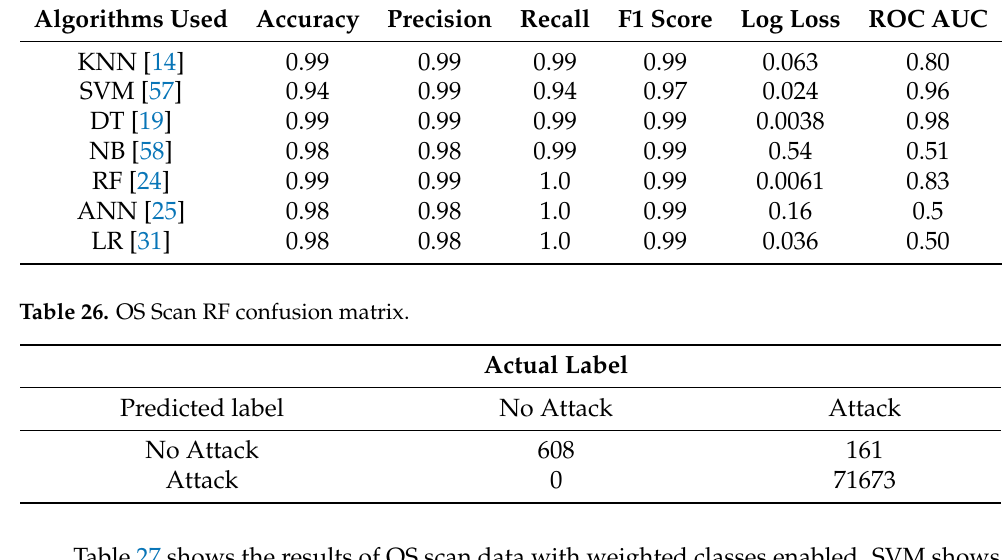
Table 25. OS Scan results.